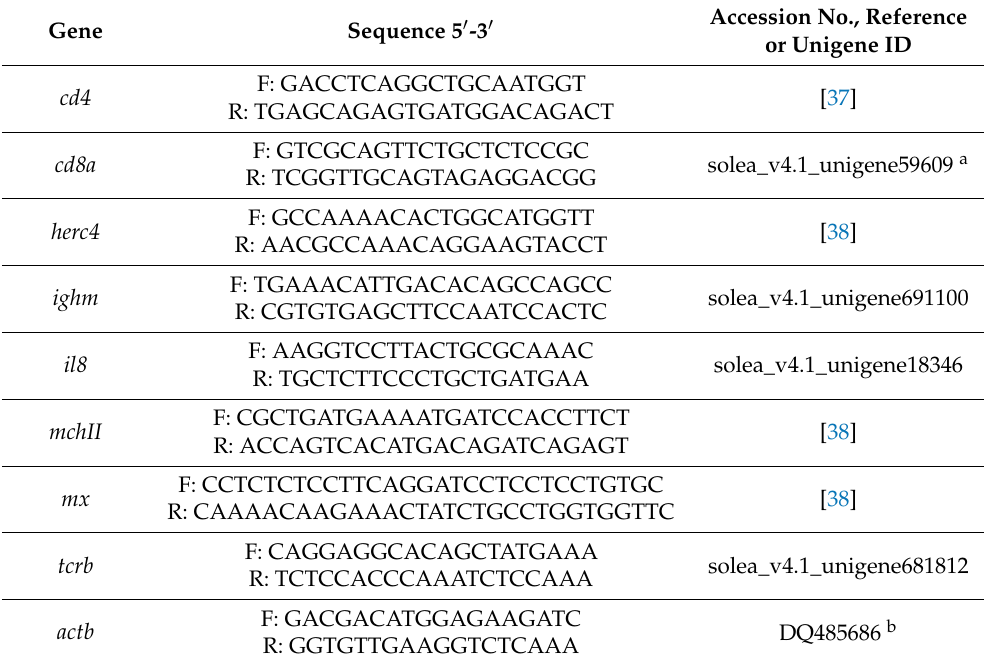
Table 1. Primer sequence used for gene expression analysis.